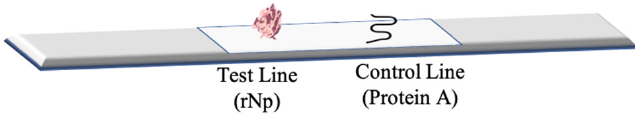
Figure 1. The configurations of the RVFV strip assembly.